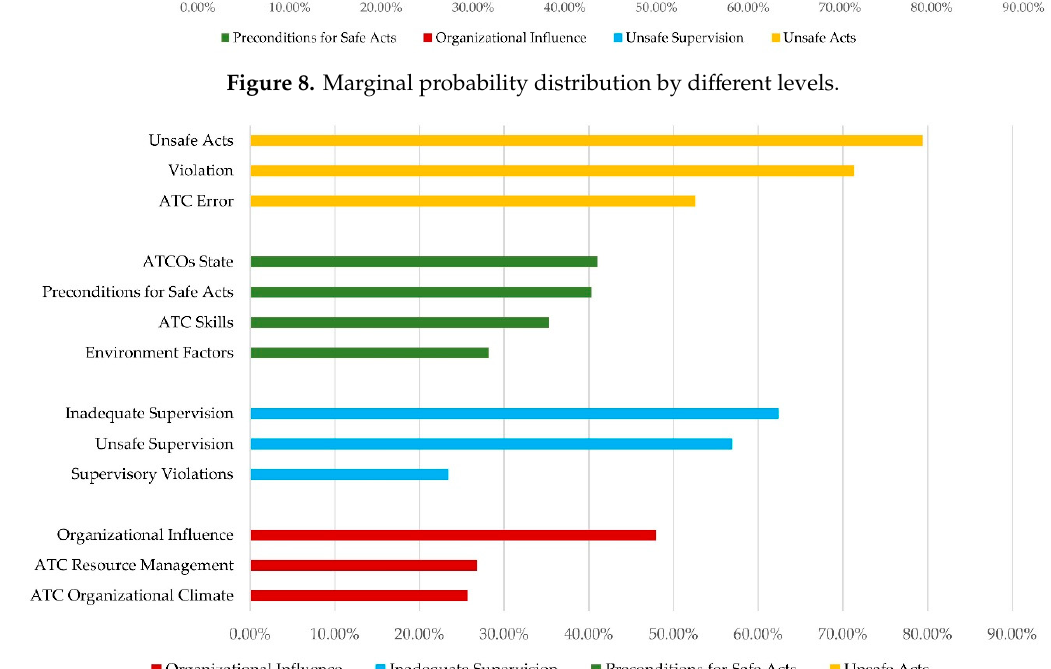
Figure 9. Posterior probabilities from Bayesian network (BN)